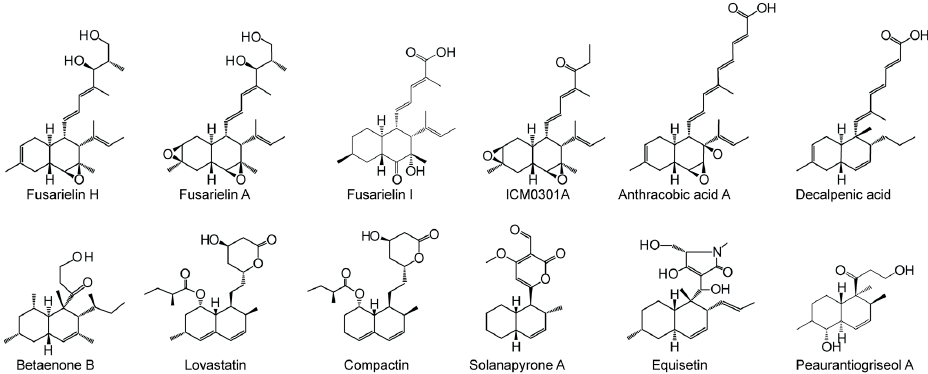
Figure 1. Structure of fusarielins and related decalin polyketides.